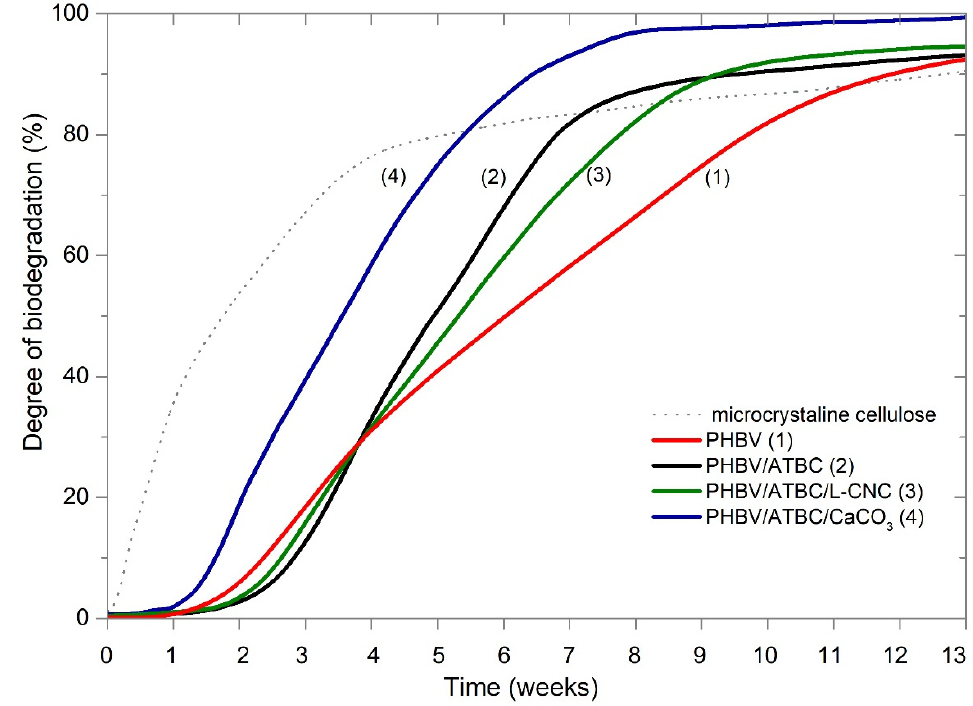
Figure 1. Biodegradation curves of PHBV biocomposites under controlled composting ISO 18455-1.